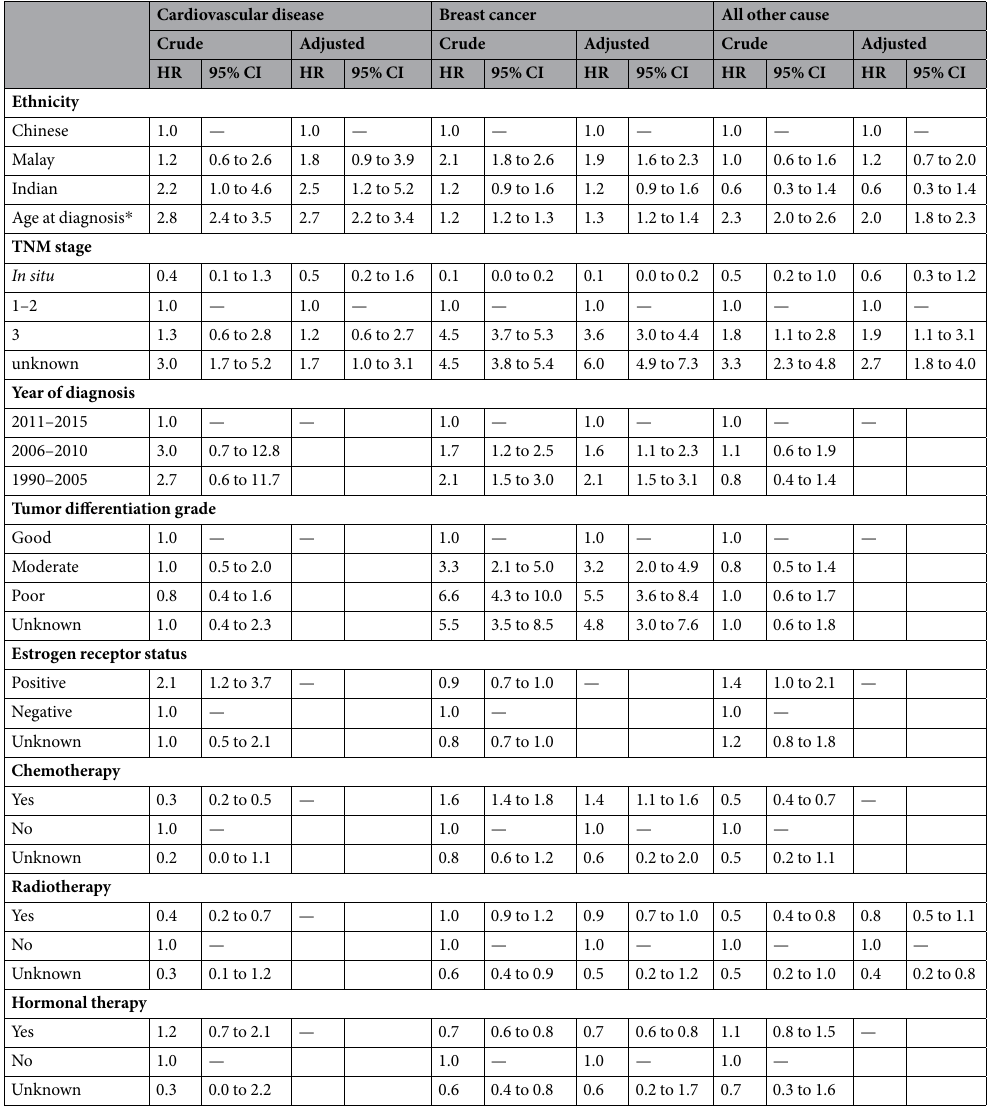
Table 2. Crude and adjusted hazard ratios of death from cardiovascular disease, breast cancer, and all other cause within 10 years of diagnosis in Southeast Asian women with breast cancer. Abbreviations: HR, hazard ratio; CI, confidence interval; TNM, Classification of Malignant Tumors. * Per 10 year increase. The HRs are estimated with a flexible parametric survival model including two internal knots for death from breast cancer and zero internal knots for death from cardiovascular disease and all other cause (i.e., assuming proportional hazards over 10 years of follow-up). Adjusted HRs for death from CVD by ethnicity are adjusted for age at diagnosis (per ten year increase) and TNM stage. Adjusted HRs for death from breast cancer by ethnicity are adjusted for age at diagnosis (per ten year increase), TNM stage, tumor differentiation grade, chemotherapy, radiotherapy, and hormonal therapy. Adjusted HRs for death from all other cause by ethnicity are adjusted for age at diagnosis (per ten year increase), TNM stage, and